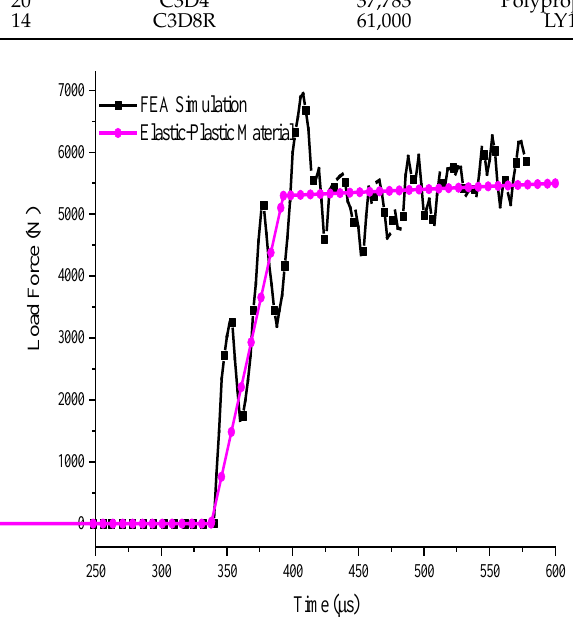
Figure 9. FEA result of PP SCS: load–time curve.